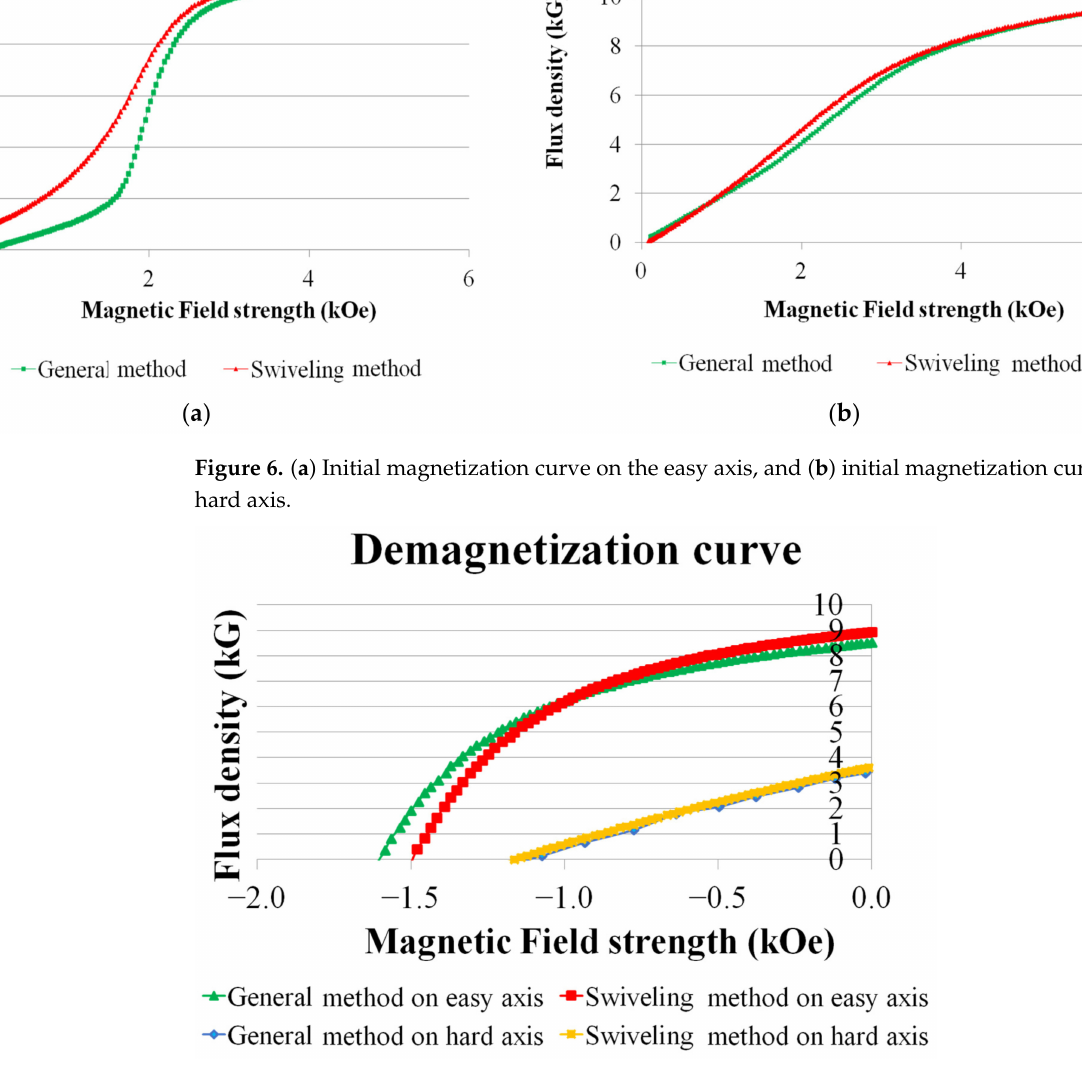
Figure 7. Comparison of demagnetization curves by the swiveling method and the general method in easy axis and hard